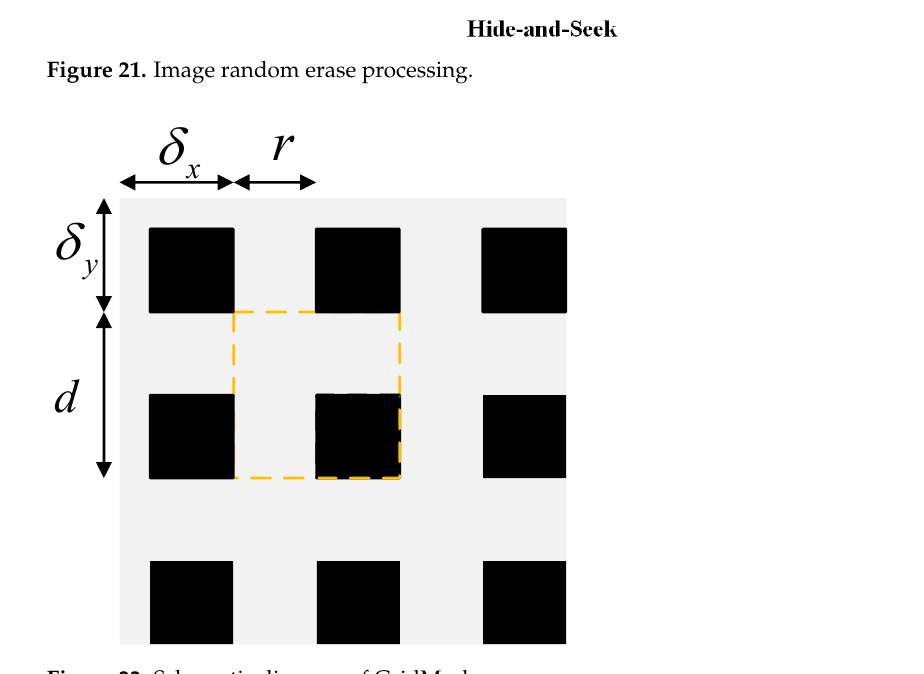
Figure 22. Schematic diagram of GridMask.